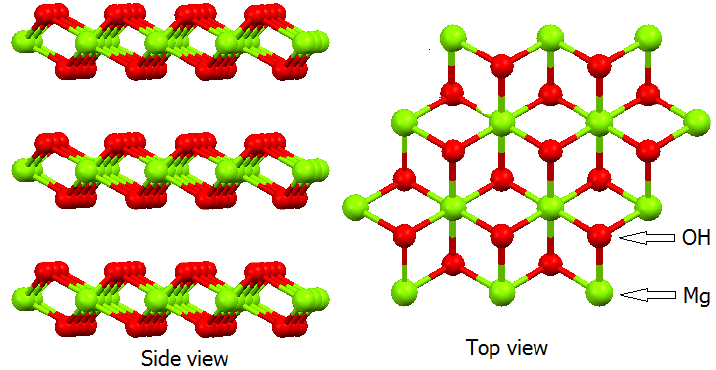
Figure 1. Brucite structure. Hydrogen atoms were removed from the structure to facilitate visualization